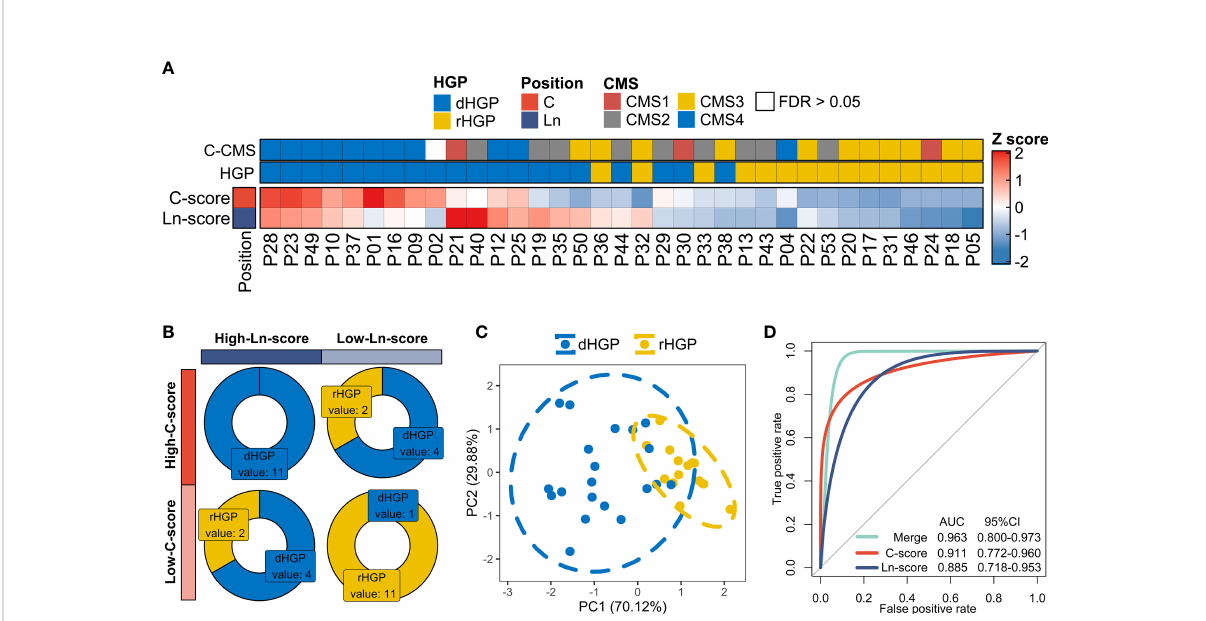
FIGURE 5 Exploration in the hypothesis of the formation of different HGPs in liver metastases. (A) Hierarchical clustering of individual C-score and Ln- score to classify 20 dHGP and 15 dHGP patients. “ Euclidean ” method was applied to calculate the distance. Column dendrograms were hide. Heatmap showing CMS subtypes of each patient. (B) Distribution of dHGP and rHGP patients strati fi ed by both C-score and Ln-score (Chi- square test, p < 0·01). The two scores were divided into high and low groups based on the median. (C) PCA plot of patients in different HGP subgroups based on the individual C-score and Ln-score. (D) The predictive values for HGP types of the C-score, Ln-score, and both were measured by ROC curves among 35